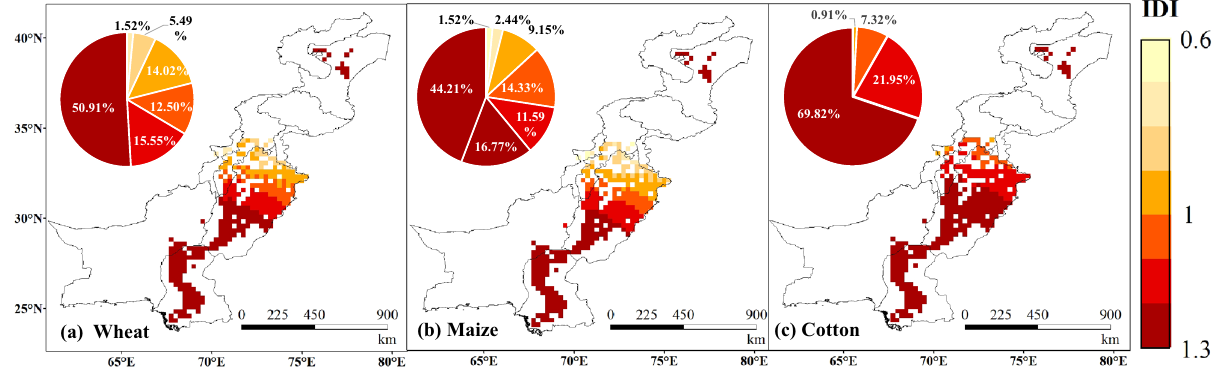
Figure 2. Spatial distribution of the average annual IDI of wheat ( a ), maize ( b ) and cotton ( c ) in the irrigated region of the China–Pakistan Economic Corridor (CPEC) from 2000 to